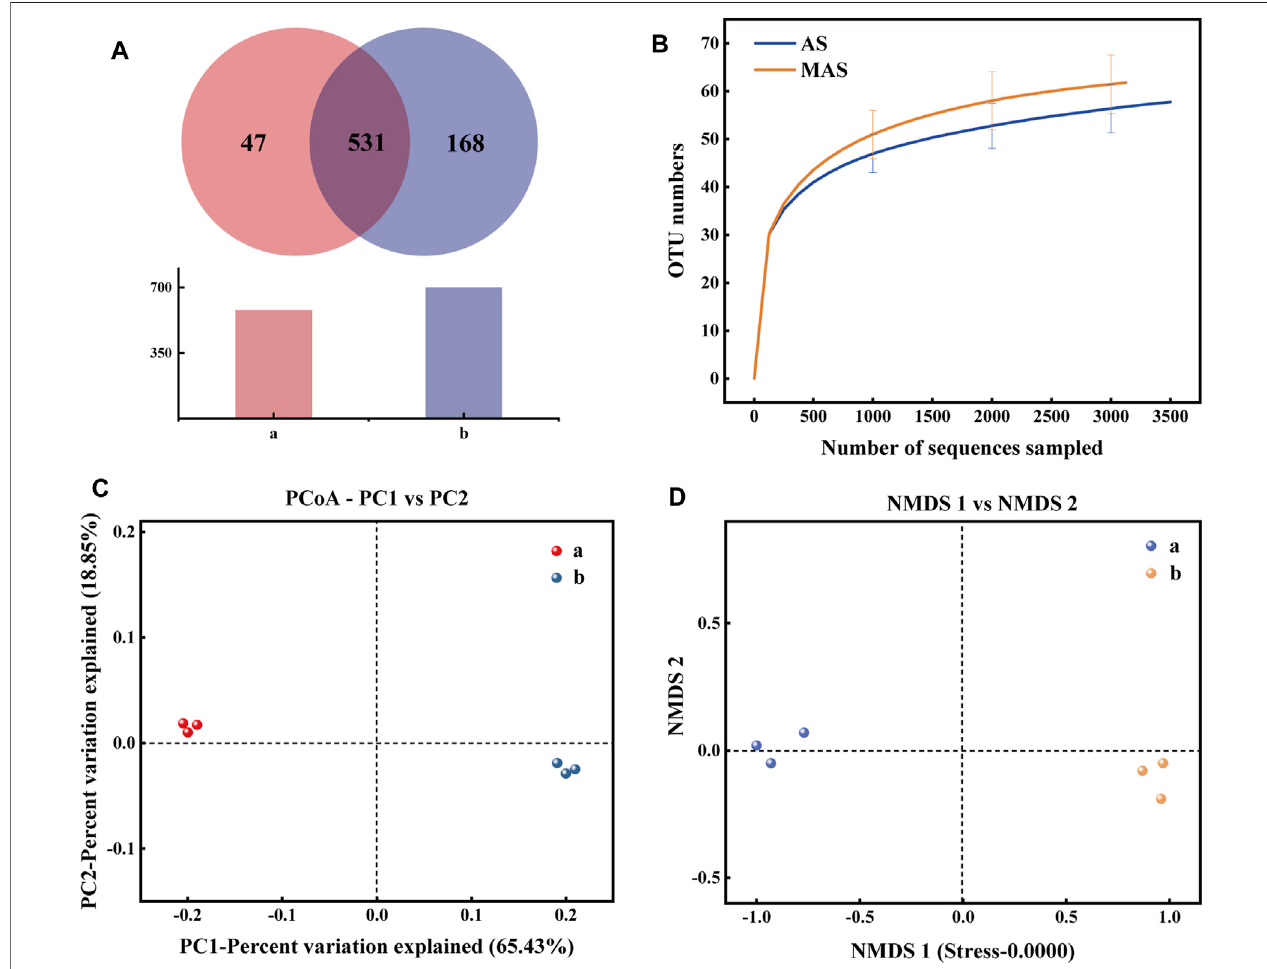
FIGURE4|(A) BacteriaVenndiagramoftwobio fi lmsamples: (A) :ASand (B) :MAS. (B) Dilutioncurvesoftwobio fi lmsamples. (C) PCoAdiagramoftwosamples: (A) : AS and (B) : MAS. (D) NMDS diagram of two samples: (A) : AS and (B) : MAS.